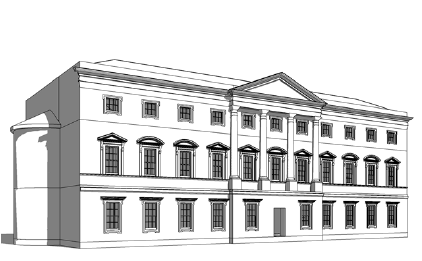
Figure 8: Initial Workflows Involved For Processing Lidar Data Sets to HBIM